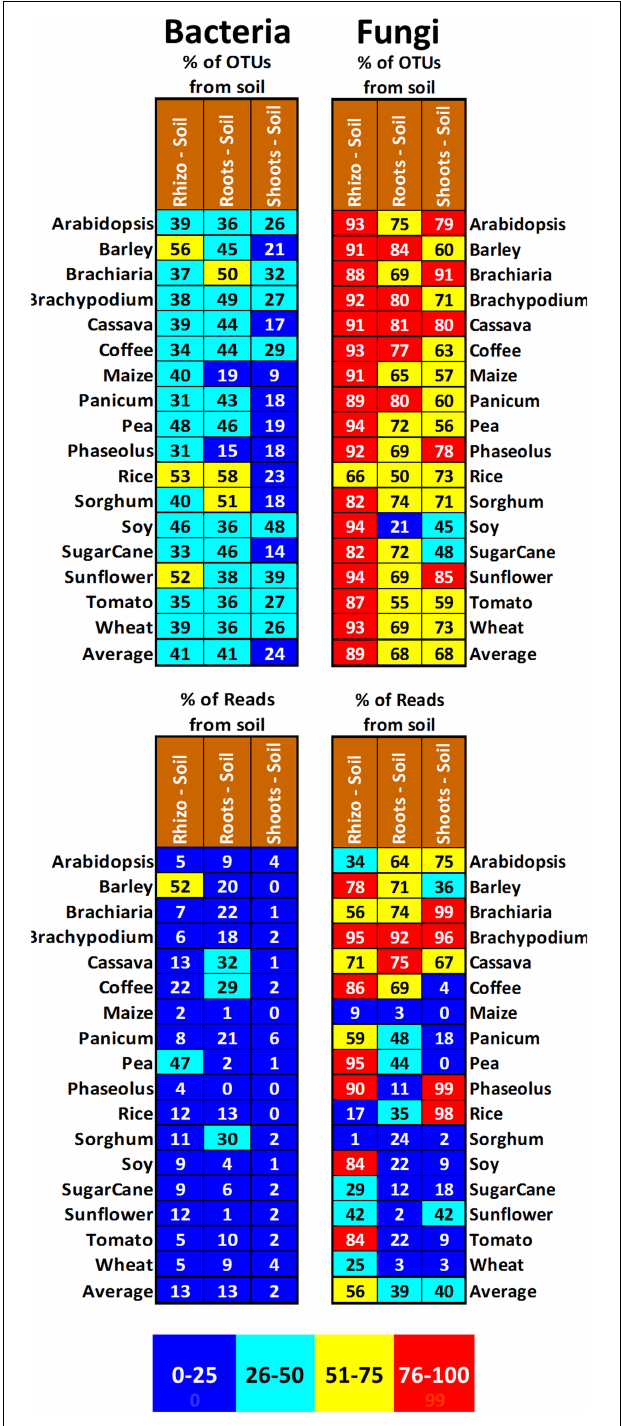
FIGURE 6 | Proportion of OTUs and reads in the shoots, roots, and rhizospheres of different plant species growing on field soil (labeled in brown) that were not observed in that species’ corresponding shoots, roots, and rhizospheres from plants grown on sterile sand. Cells are shaded to reflect proportion, with 0–25% being blue, 26–50% being green, 51–75% being yellow, and 76–100% being red. An average across all the plant species is shown at the bottom of each